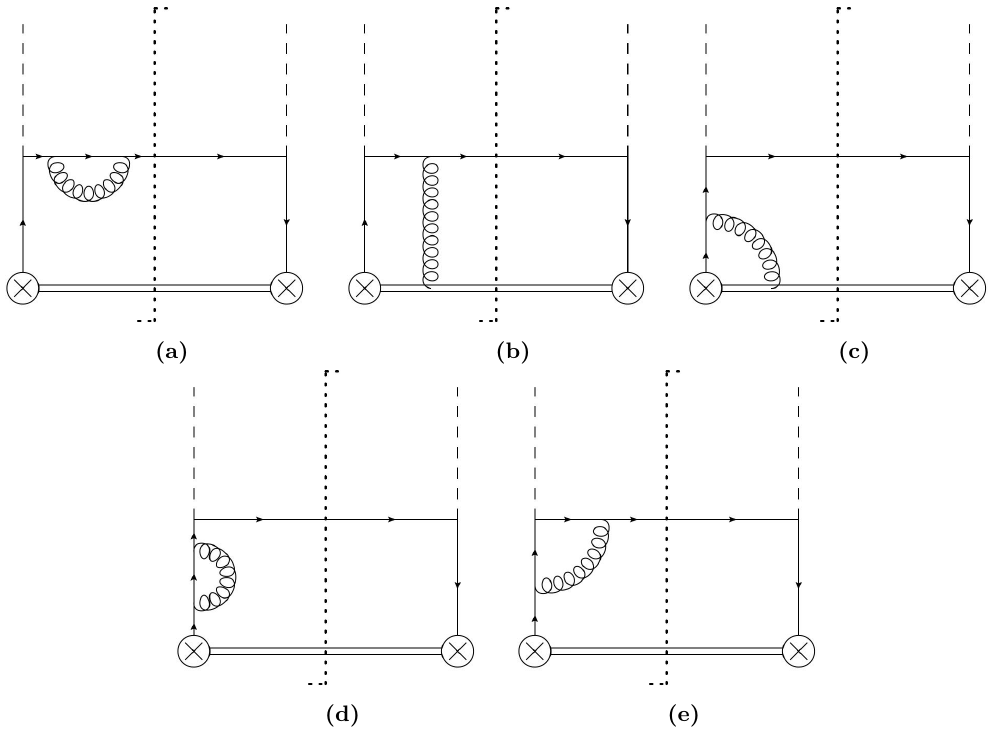
Figure 4. The diagrams for the virtual corrections to D t → H . All diagrams have a conjugate diagram which is not shown.